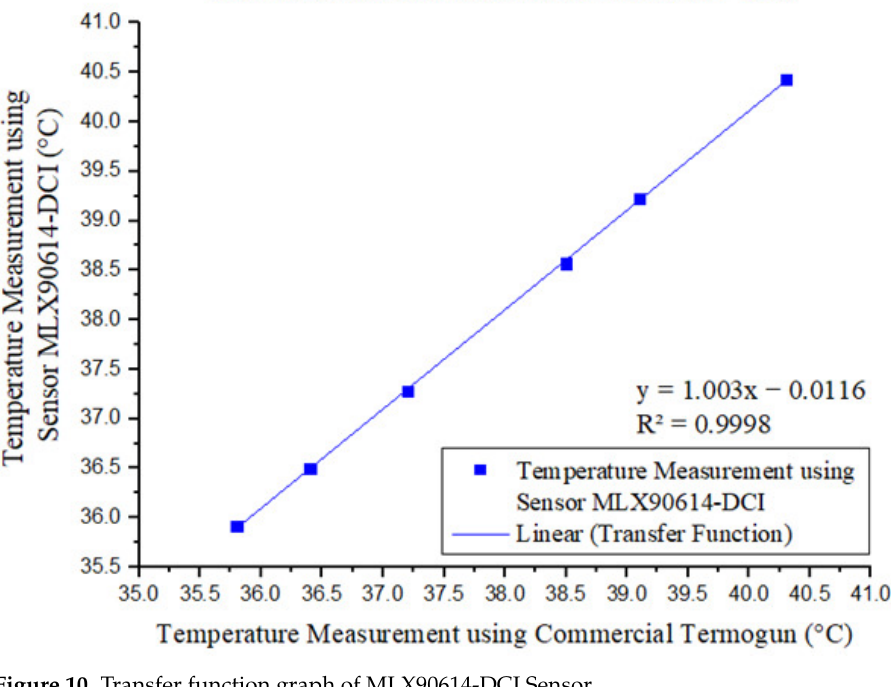
Figure 10. Transfer function graph of MLX90614-DCI Sensor.